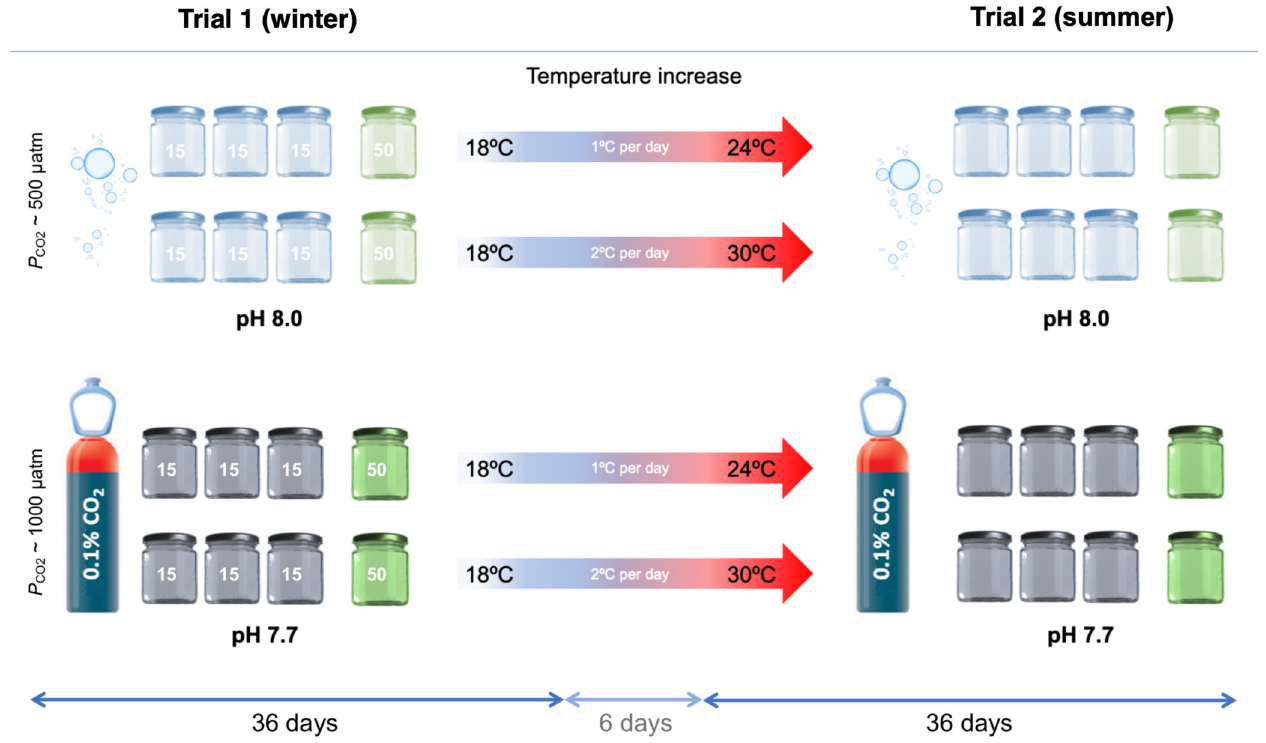
Fig 1. Experimental design. Trial 1 mimicking current and future winter conditions and Trial 2 mimicking current and future summer conditions. Light blue flasks correspond to P CO2 ~ 500 ppm treatments and grey flasks to P CO2 ~ 1000 ppm treatments. Additional green flasks were used to study zooxanthellae density inside Cotylorhiza tuberculata